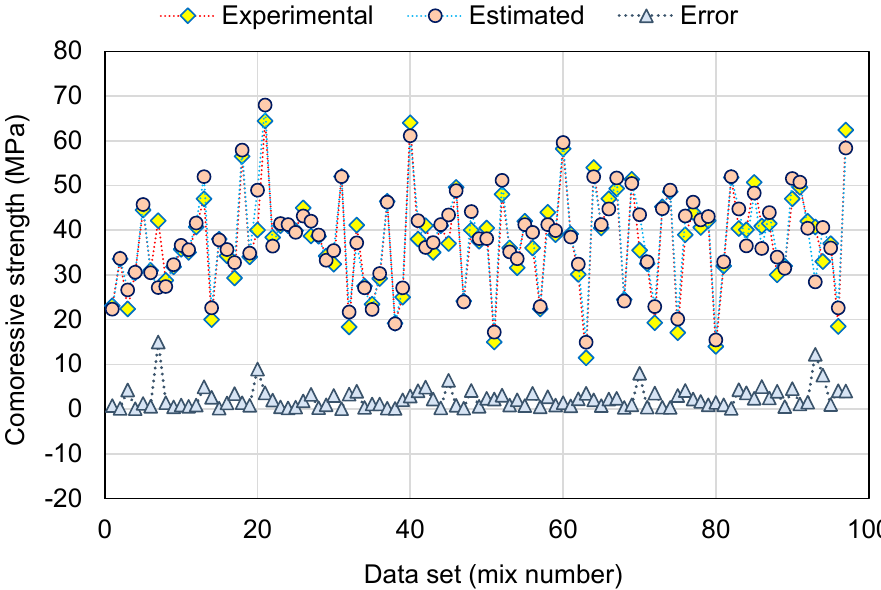
Figure 15. Distribution of experimental, estimated, and error values for the random forest model.